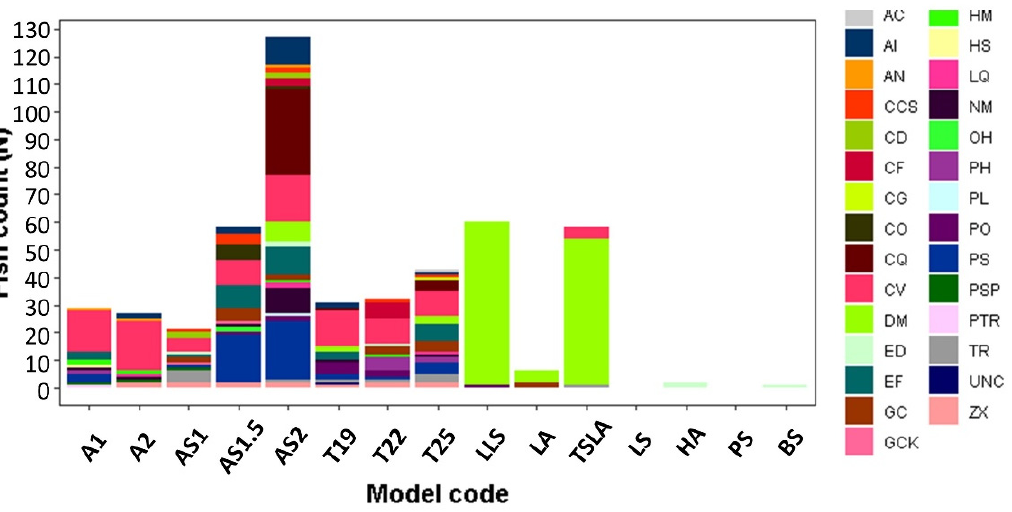
Figure 8. Richness of fish species interacting with the various models. The natural structures observed are shown in the marked area. DM is the abbreviation for Dascyllus marginatus . For a detailed explanation of the codes of shelters and an abbreviation explanation for the rest of the species, see the Supplementary Material.